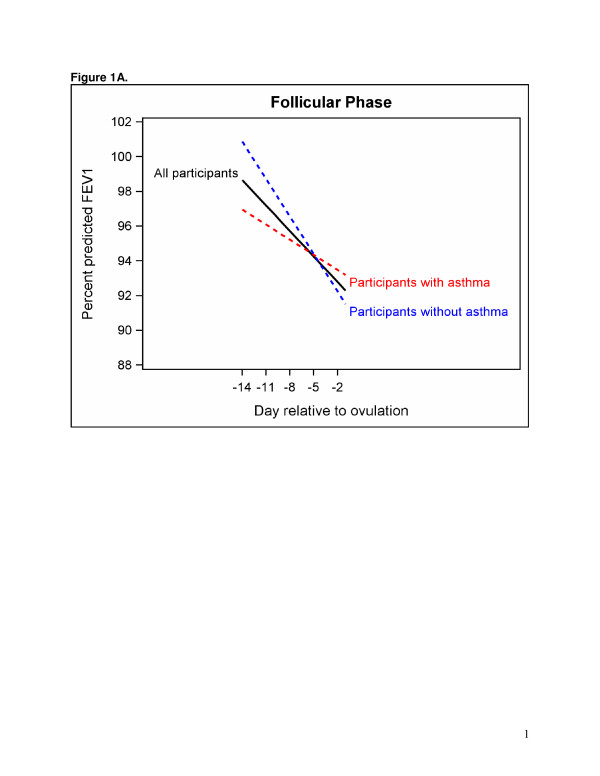
A plot of the association between day relative to ovulation and percent predicted FEV1 in the follicular phase. A. The blue dashed line is for participants without asthma and the red dashed line is for participants with asthma. The solid line is the groups combined. B. A plot of the association between day relative to ovulation and percent predicted FEV1 in the luteal phase. The blue dashed line is for participants without asthma and the red dashed line is for participants with asthma. The solid line is the groups combined.